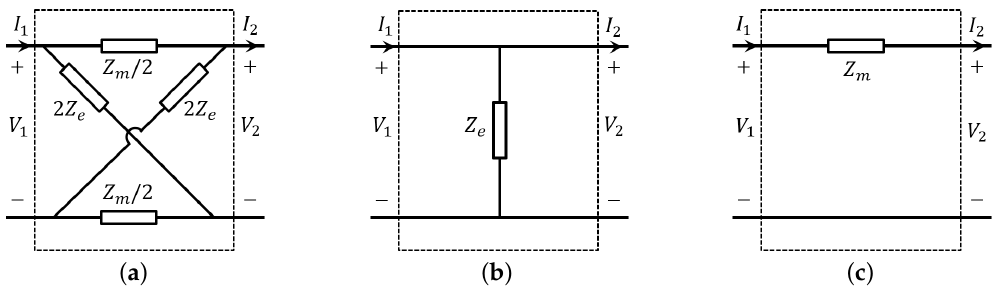
Figure 10. Equivalent circuit model of two-dimensional surfaces: ( a ) generalized bridged-T model ( b ) shunt-impedance model ( c ) series-impedance